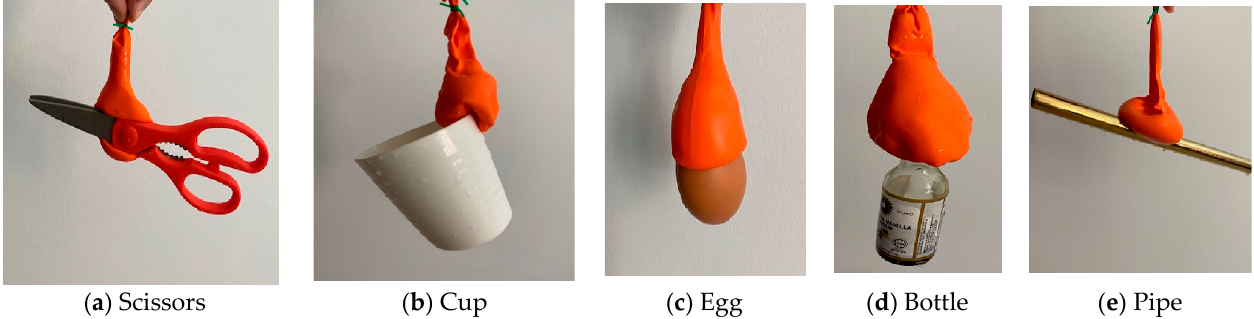
Figure 2. Demonstration of concept showing the picking up of different objects using a party balloon semi-filled with coconut oil frozen around the object to be picked up.